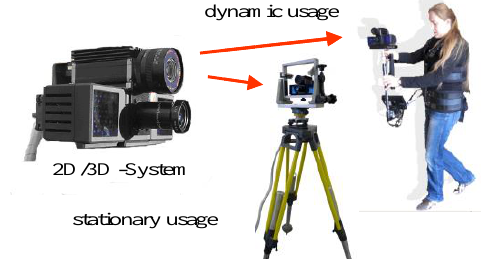
Figure 1 Dynamic usage of the 2/3D camera system (for recording) and stationary usage (for surveying and recording) In order to allow for free movement in space (tab. 2, C), the 2D/3D camera system was mounted to a Steadicam (stabilizing mount) as used for the filming of motion pictures.